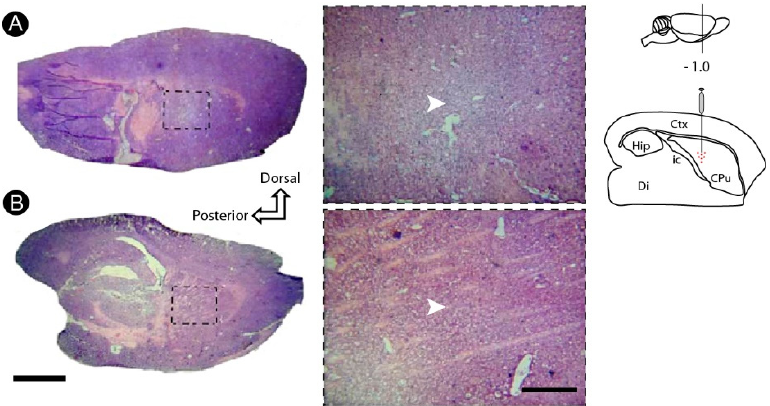
Figure 2. Basic histology (Nissl staining) following striatal endothelin − 1 (ET − 1) injection. There was a loss of tissue after seven post-lesion days (7PLD) ( A ), identified by a well-defined region of pallor, not observed in the control animal ( B ). Dashed squares in lower magnifications point to the location where higher power was obtained. Arrowheads point to the center of the injection. Drawings at the left side of the figure show the anatomical location of the ET − 1 injection site into the striatum. Ctx: cortex; CPu: caudate putamen (striatum); Di: diencephalon; Hip: hippocampus; ic: internal capsule. Scale bars: 2 mm (lower magnification); 200 μ m (enlargements).